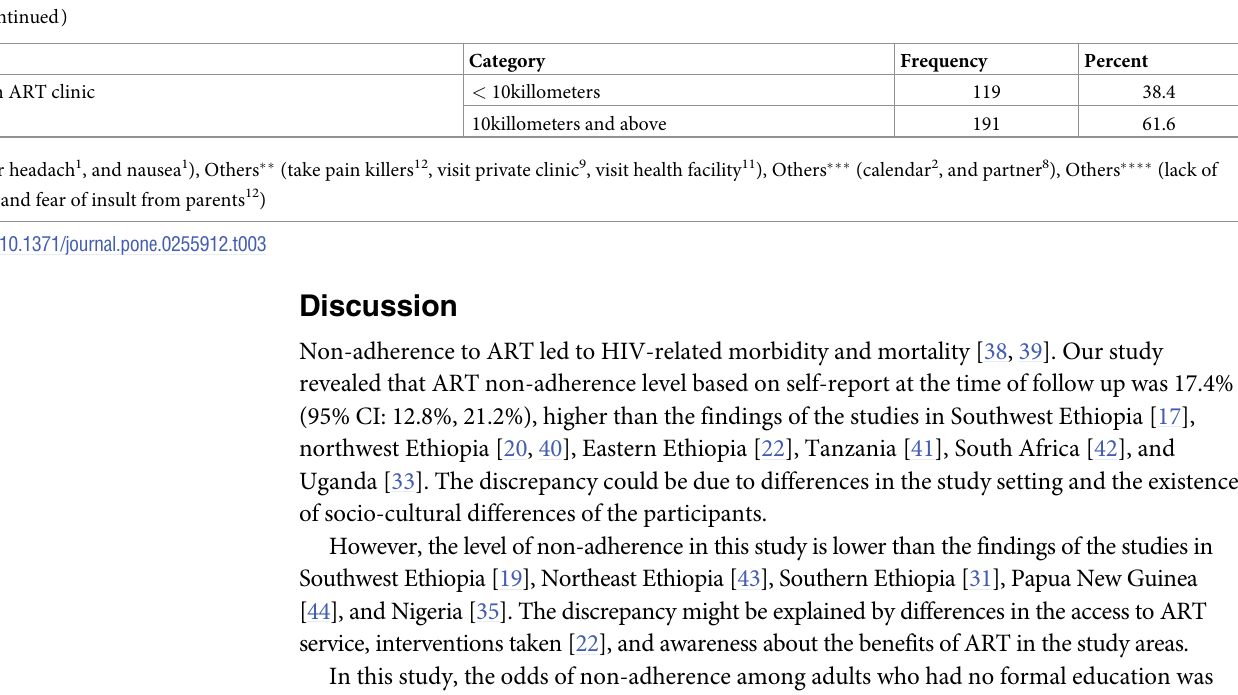
[44], and Nigeria [35]. The discrepancy might be explained by differences in the access to ART service, interventions taken [22], and awareness about the benefits of ART in the study areas. more than five times higher compared to those who attended secondary education and above.